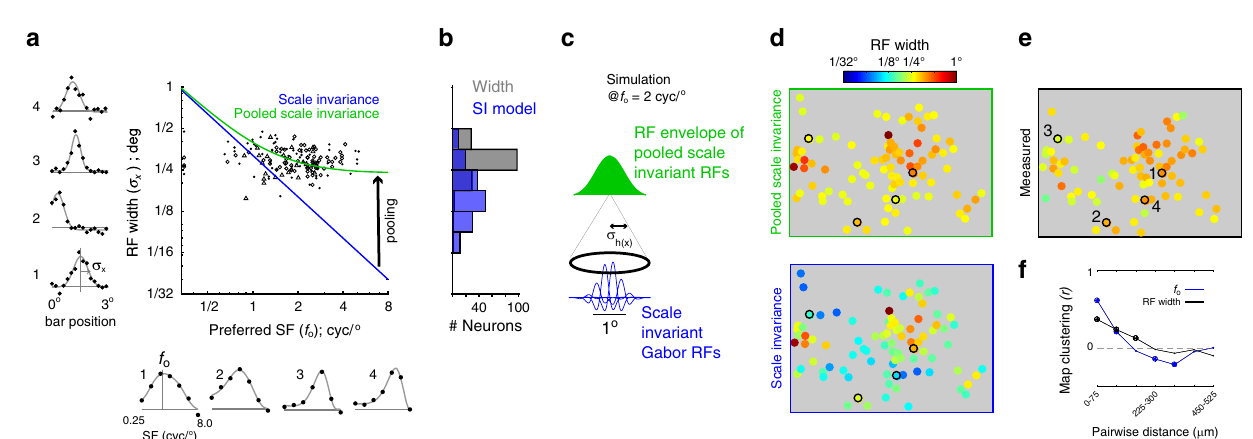
Fig. 3 Receptive fi eld width as a function of preferred SF ( f o ). a The scatter plot compares f o to RF width from three ROIs, each indicated by a different symbol. See Table 2 for joint statistics. The fi ve data points at the extreme left of the x -axis were “ low pass ” (see “ Methods ” ). To the left of the y -axis are position tuning curves (black dots) and Gaussian fi ts (gray) of four example neurons in one ROI outlined and enumerated in e . Below the x -axis are the SF tuning curves and fi ts of the same four cells. b Distribution of measured RF width and the scale invariance prediction of RF width based on f o . c Illustration of the pooling model in the spatial domain, at f o = 2 cyc/°. At bottom are the 1D Gabor functions from the model of scale invariance. They are shifted and weighted according to the Gaussian in the pooling model ( σ h ( x ) = 0.24°). The superposition of the Gabors ’ energy (i.e. their envelopes) yields the wider green Gaussian on top, which is the output of the pooling model. d Bottom and top panels are the predicted map of RF width by plugging f o into the scale invariance model and pooled scale invariance model, respectively. The yield in these map are based on tuning fi ts to the random grating stimulus (see “ Methods ” ). e Map of the measured RF width. The yield in d is different from e because they are based on tuning fi ts from two separate stimulus blocks, the random gratings and random bars (Fig. 2c, j), respectively. Like the map in e , the scatter plot in a showed the intersection of the yield between the two different stimulus blocks. f Pearson correlation coef fi cient between neuron pairs, within 75 μ m cortical distance bins, using all three ROIs in the study. The symbol at each distance bin indicates the correlation coef fi cient ’ s signi fi cance: Closed dot is p >0.01, asterisk is p <0.01, asterisk and open circle is p <0.001.